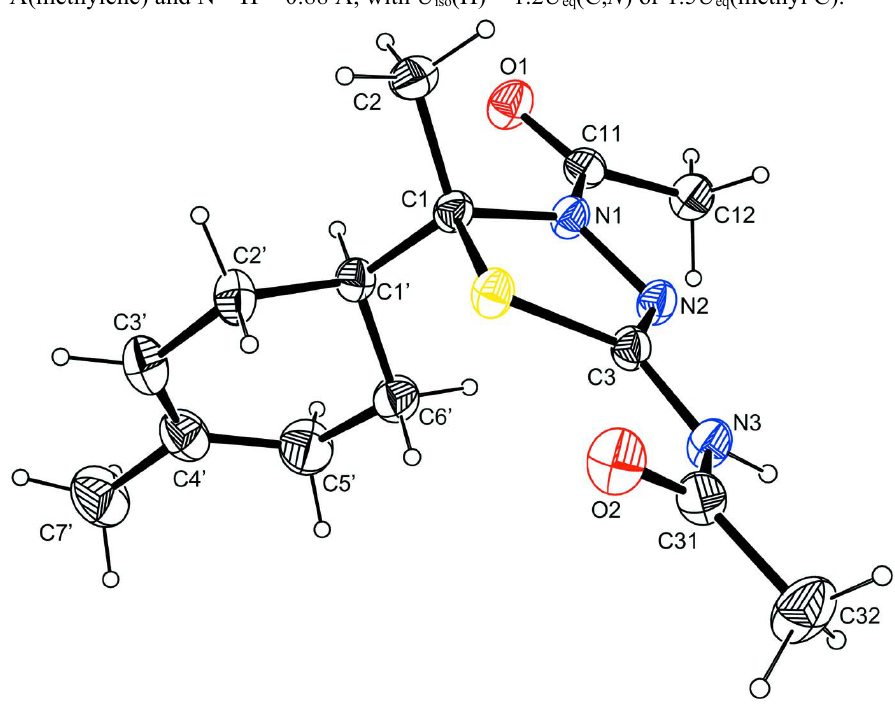
The molecular view of compound (II), showing the atom-labelling scheme. Ellipsoids are drawn at the 50% probability